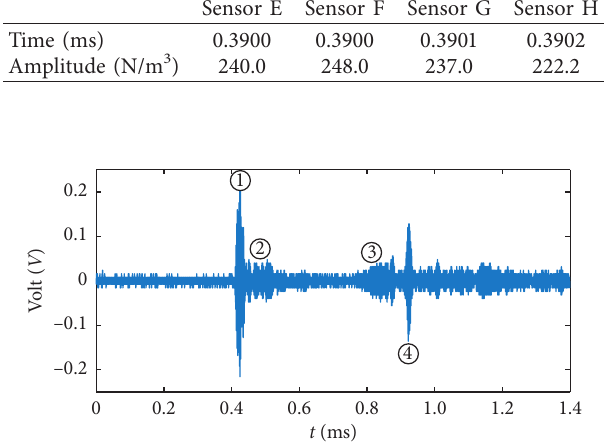
Figure 4: Oscilloscope signal of sensor E on the steel plate.